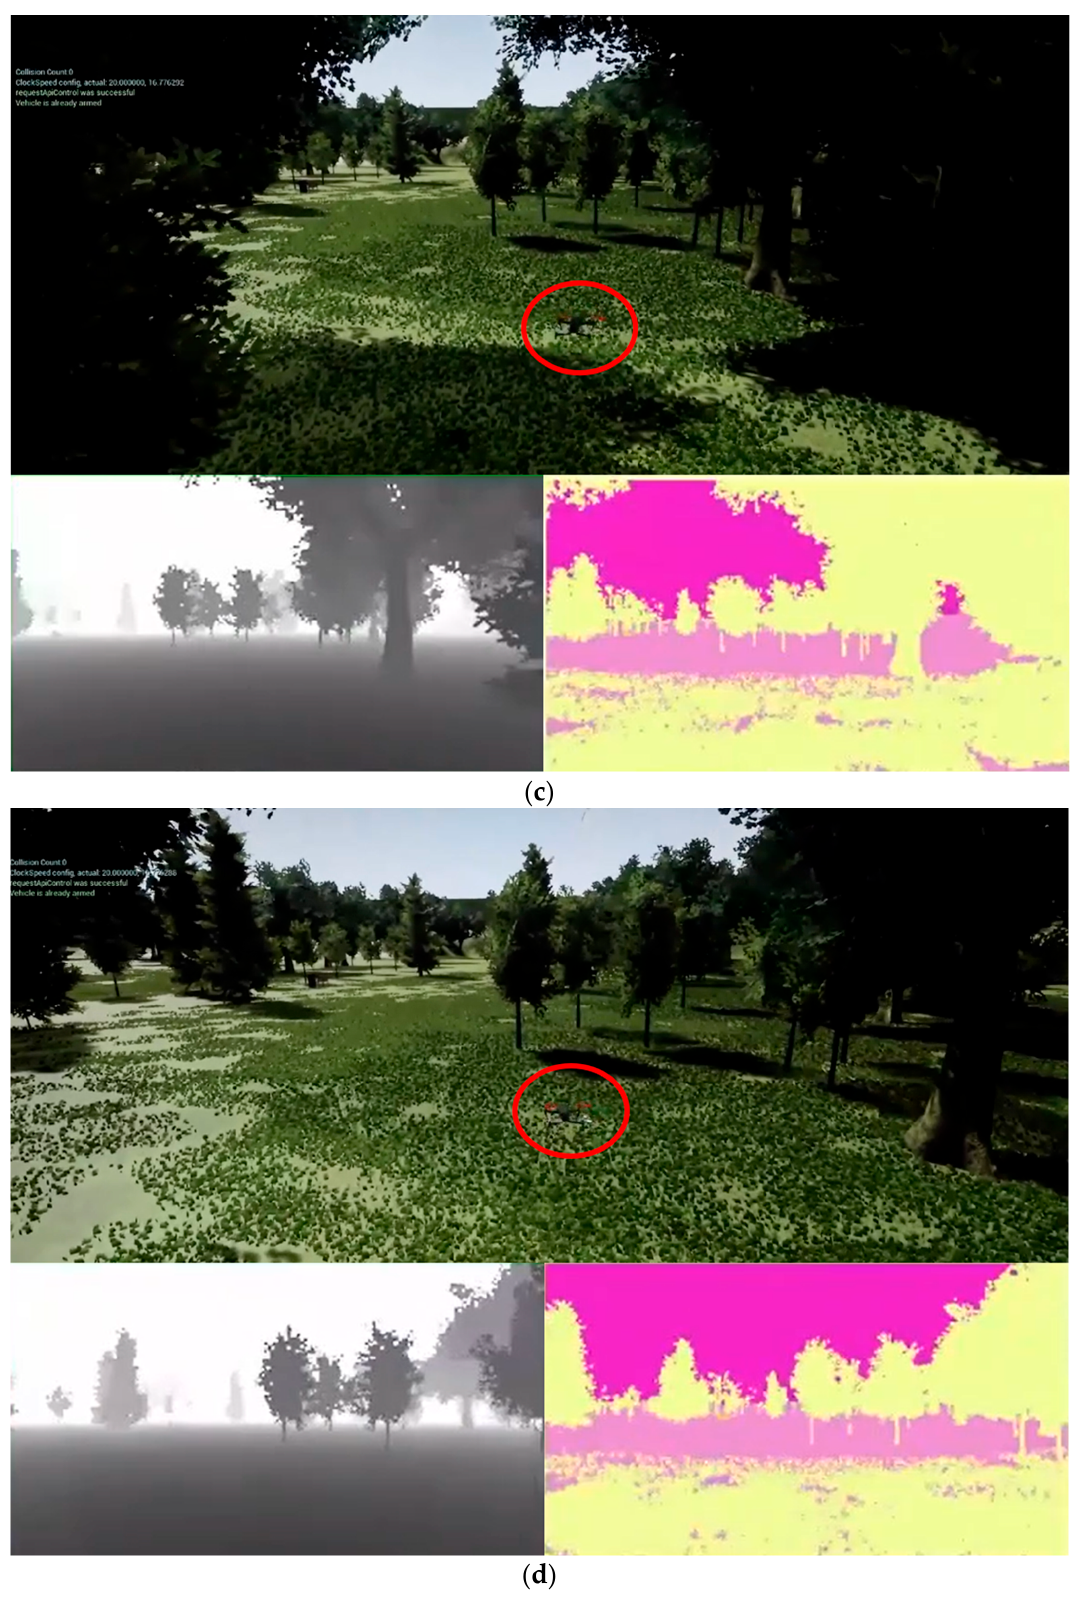
Figure 40. The experiment for testing obstacle avoidance in the simulation environment, part 2, ( a ) is the starting point, ( b ) shows the drone moves closer to the trees, ( c ) shows the drone does not fly in a straight line, ( d ) shows the UAV has successfully passed through the obstacles.